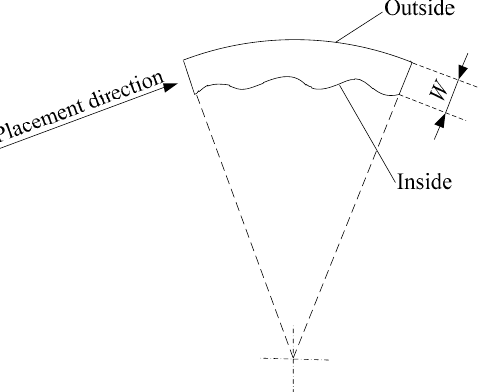
Figure 4. A schematic diagram of the generation of fiber waviness.